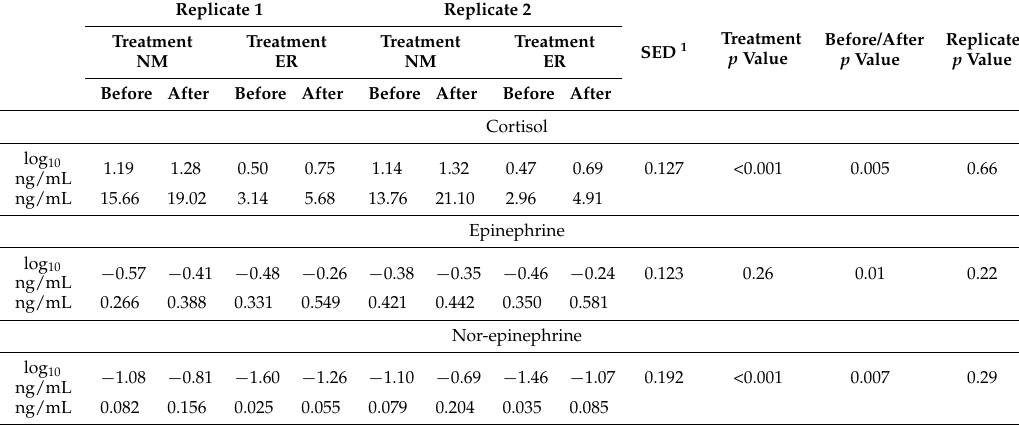
Table 2. Least square mean concentrations of stress hormones before and after treatment in Naïve Marshalled calves (NM) and Experienced Roped (ER) calves. There were no significant ( p < 0.05) two way interactions between the factors treatment, before/after and replicate.